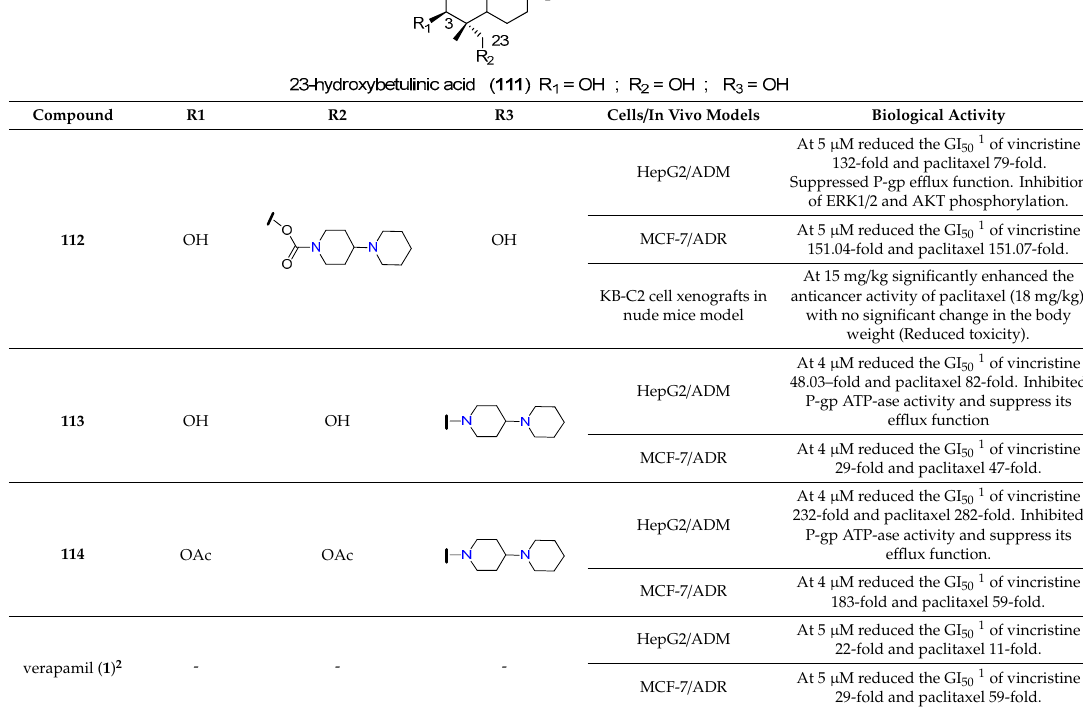
Compound Cells / In Vivo Models Biological Activity